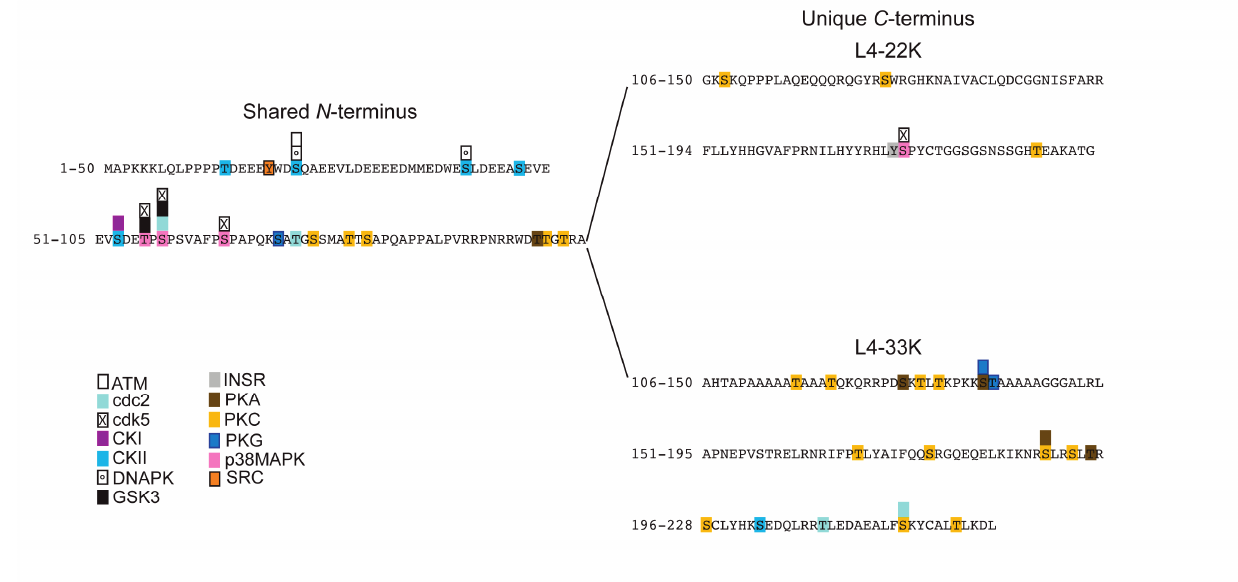
Figure 6. Predicted phosphorylation sites of Ad5 L4-33K and L4-22K proteins. The shared N -terminal region is shown on the left, and the unique L4-22K and L4-33K C -termini are on the right. The result of the phosphorylation sites prediction performed with NetPhosK 1.0 is graphically shown as boxes for the respective kinases in the corresponding predicted residue, according to the color code in the figure. Amino acids potentially phosphorylated by more kinases are marked by piled boxes, according to the kinases and the respective score (lowest score on top and highest on the protein